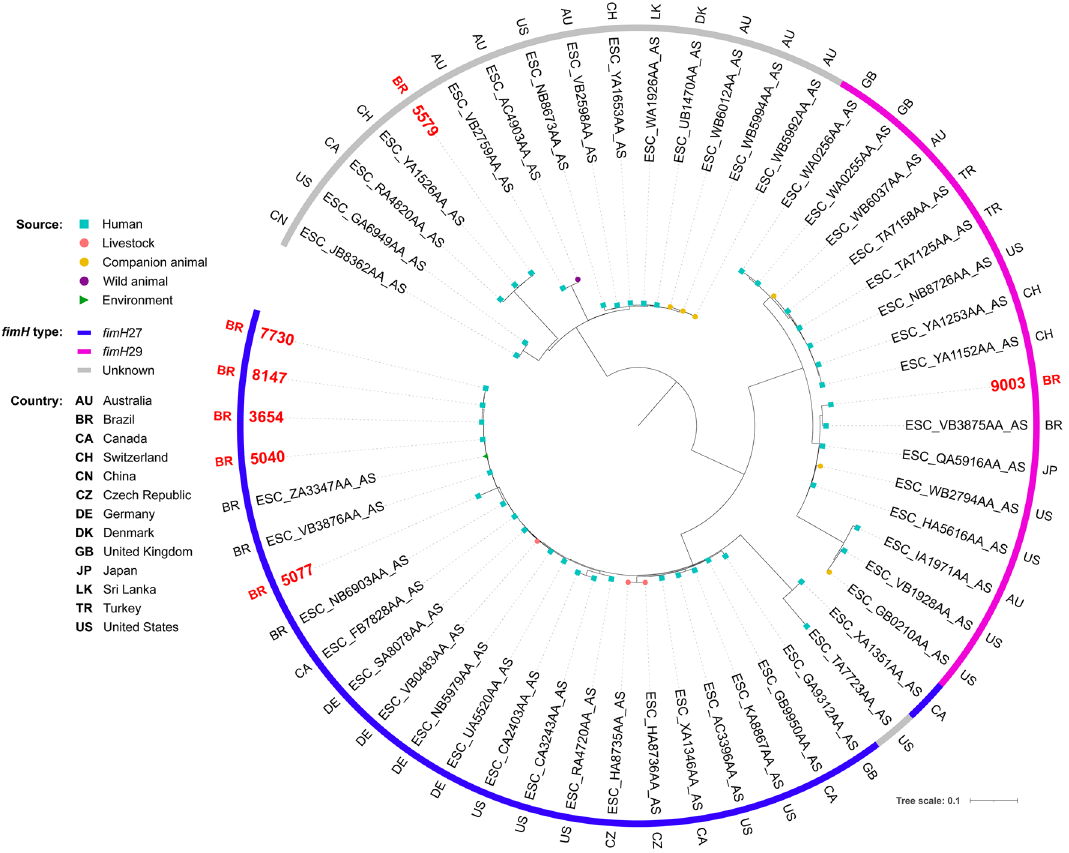
Figure 7. Phylogenetic tree of 56 Escherichia coli ST648 strains, their source, country of collection and fimH